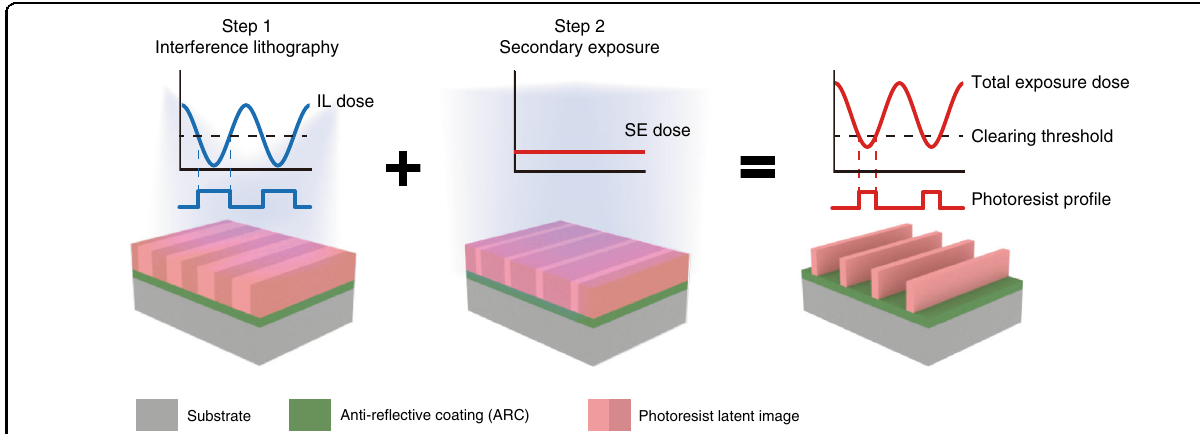
Fig. 1 The schematic diagram of the IL-GPSE process. Step 1, a two-beam IL is performed on the photoresist to form periodic latent exposed regions with sinusoidal dose pro fi le. Step 2, a secondary exposure follows the IL exposure and increases the effective dose applied to the photoresist which increases the portion of photoresist that receives above-threshold dose, and then leaves less photoresist after